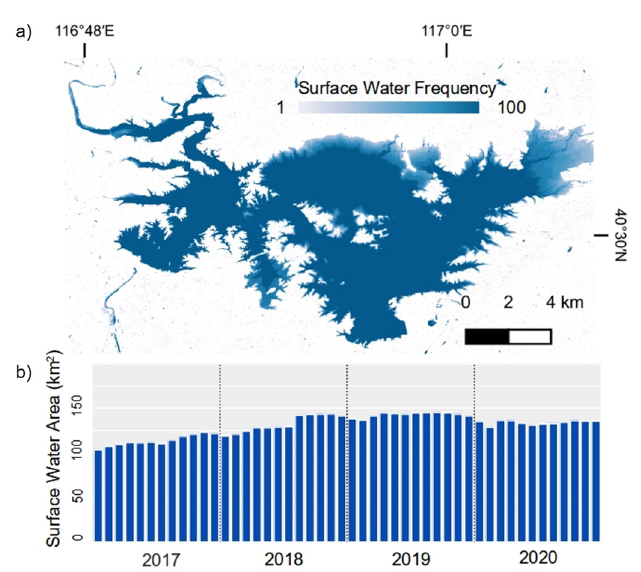
Figure 5. The multi-annual surface water frequency (a) and the associated inter-annual monthly water dynamics (b) for the Miyun reservoir.